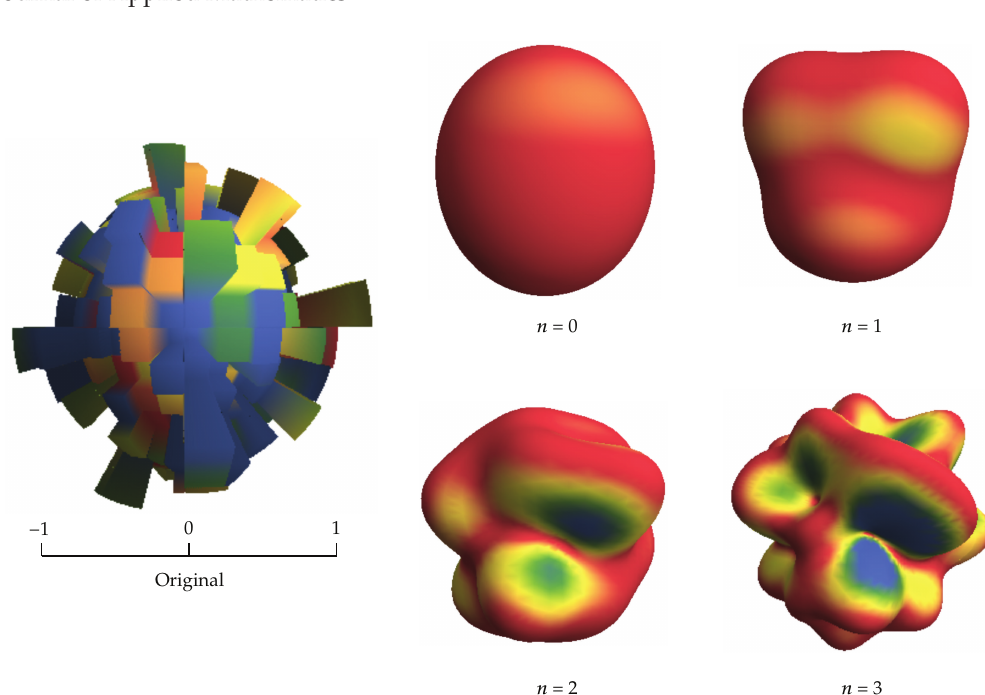
Figure 8: Original vector-valued ODF sampling from N (cid:3) 1 . 0 , 0 . 3 2 (cid:4) and its approximate ODFs using sym- metric characterization in